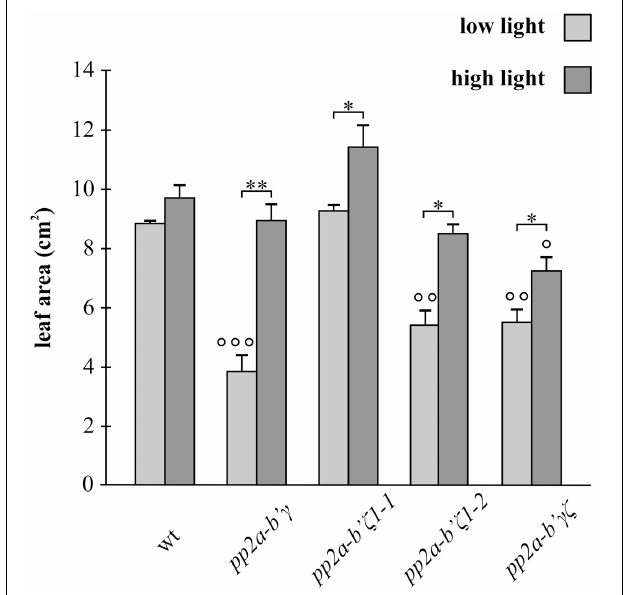
FIGURE 3 | A comparison of the rosette leaf areas of the pp2a-b’ γ , pp2a-b’ ζ 1-1 , pp2a-b’ ζ 1-2 , and the pp2a -b’ γζ double mutant grown under low and high light conditions. Leaf area measurements were performed on plants that had been grown for 2 weeks under low light (250 μ mol m − 2 s − 1 ) and then either maintained for a further 7 days under low light growth conditions or transferred to high light (800 μ mol m − 2 s − 1 ) for 7 days. The results are average values ± standard error values, n = 5. ∗ p < 0 . 05; ∗∗ p < 0 . 01 in Significance given from analysis by student’s t -test and One-Way ANOVA analysis of LL and HL values for each genotype, as follows ◦ p < 0 . 05; ◦◦ p < 0 . 01; ◦◦◦ p < 0 . 001 in Student’s t -test and One-Way ANOVA comparisons between the mutant lines and wild type under LL or HL light